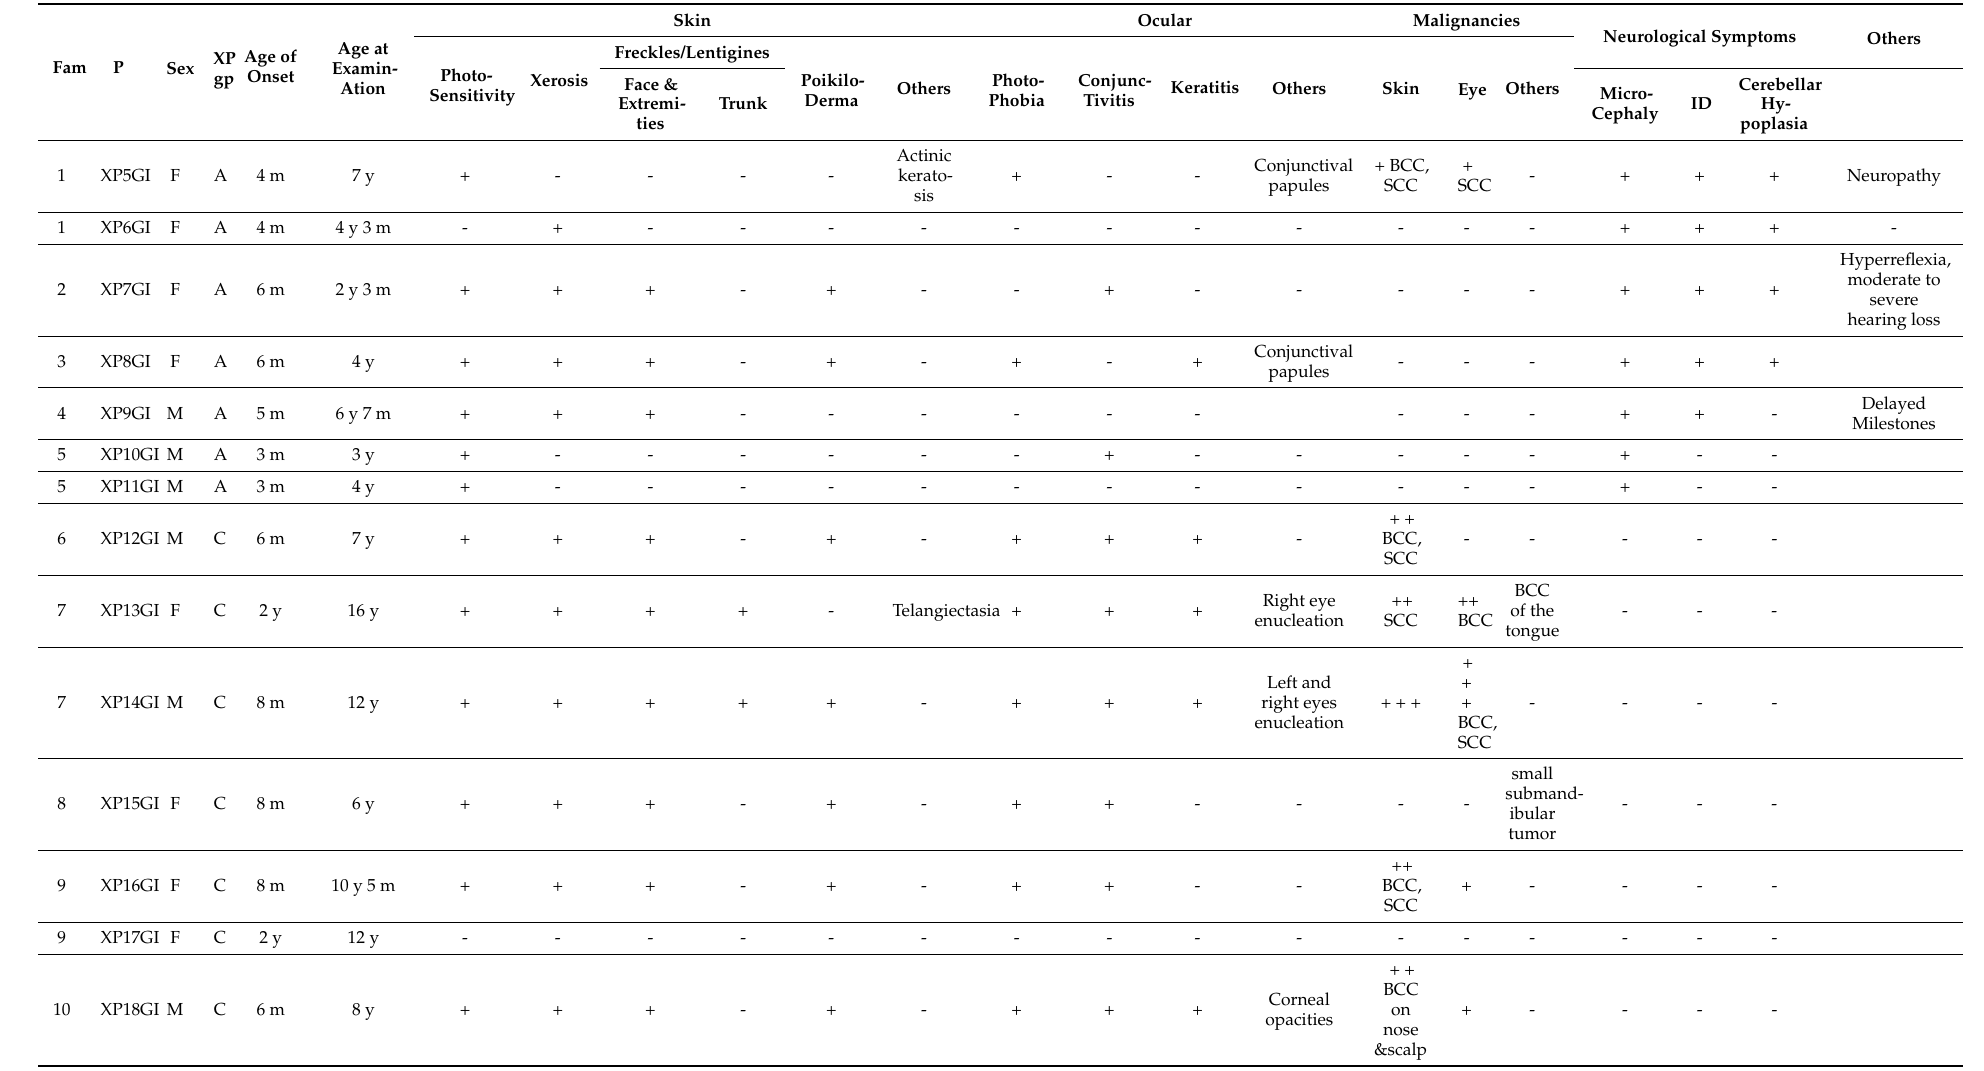
Table 2. Clinical manifestations of the studied Egyptian xeroderma pigmentosum (XP)